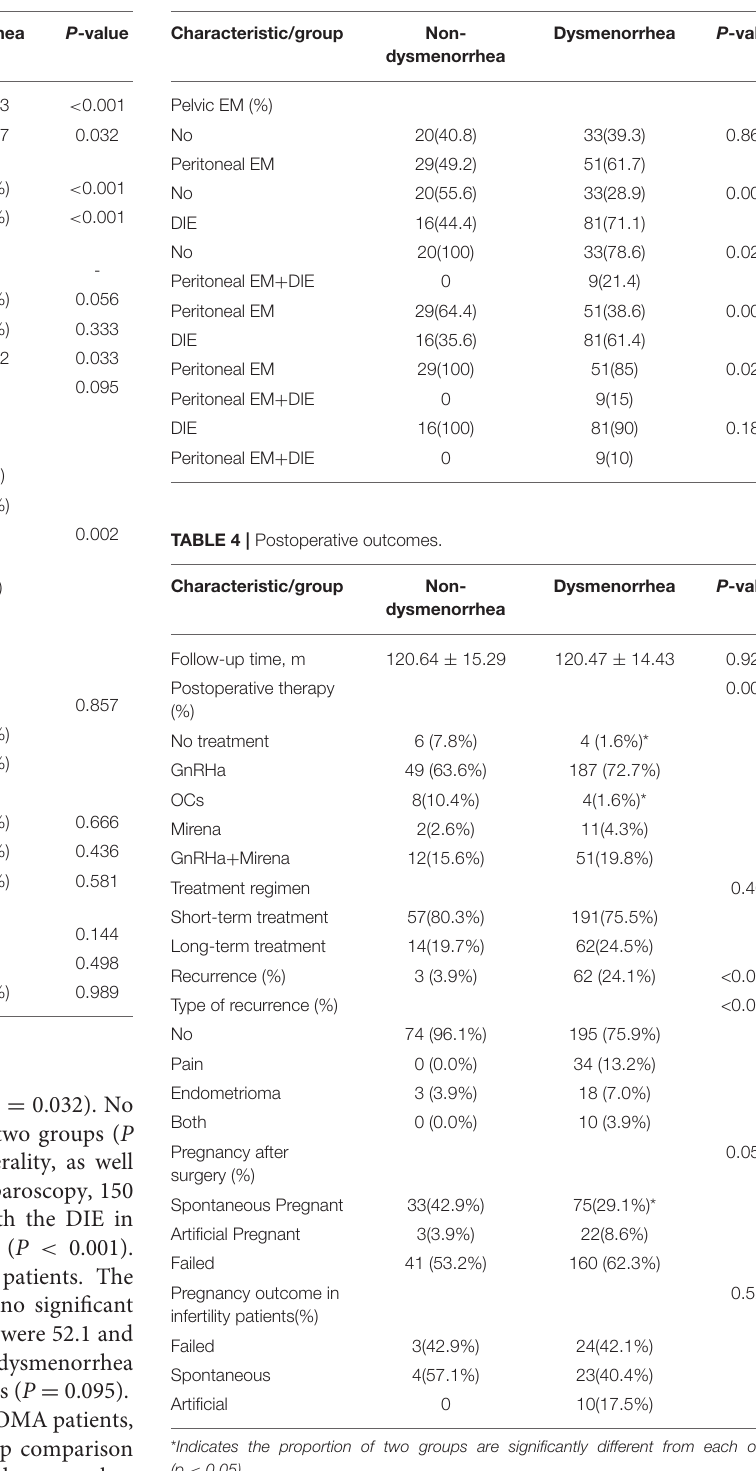
TABLE 3 | Concurrent pelvic endometriosis conditions.